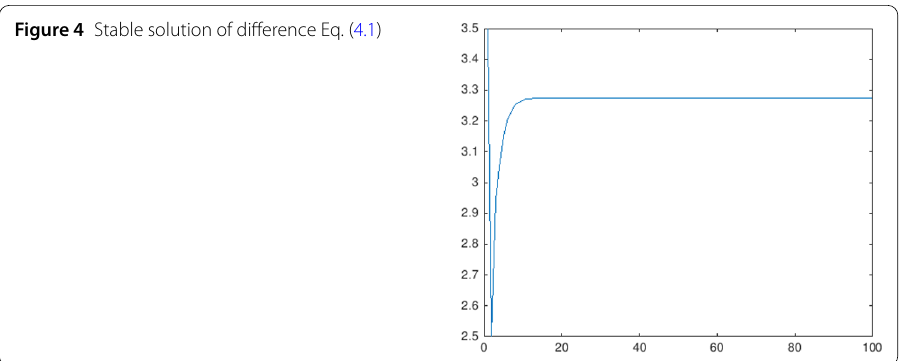
Figure 4 Stable solution of difference Eq.